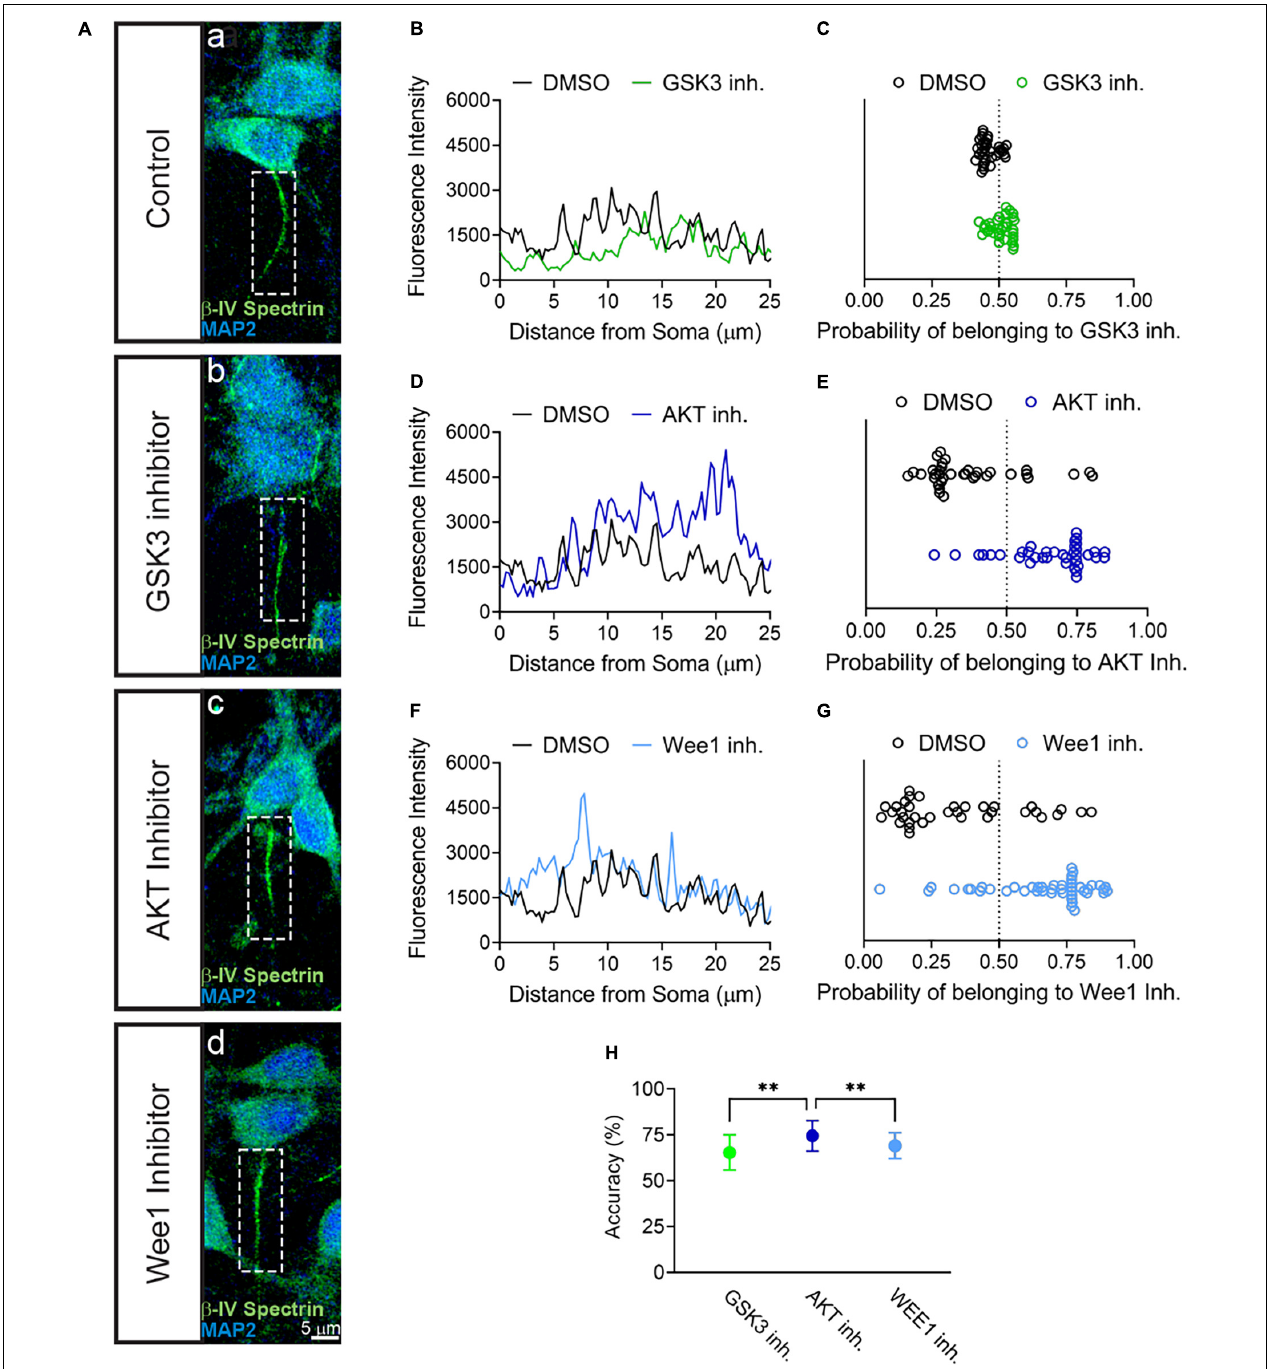
FIGURE 4 | SVM Classification of β IV Spectrin fluorescent intensity accurately sorts AKT inhibitor treated cells from control. (A) Representative images of AIS from neurons treated with (a) 0.5% DMSO (control), (b) 5 µ M GSK3 inhibitor CHIR99021 (c) 25–30 µ M AKT inhibitor triciribine, (d) 5–10 µ M Wee1 kinase inhibitor II with MAP2 in blue and β IV spectrin in green. (B,D,F) Profiles of AIS in panel (a–d) showing first 25 µ m used for SVM analysis of neurons treated with (B) DMSO versus GSK3 inhibitor, (D) DMSO versus AKT inhibitor and (F) DMSO versus Wee1 kinase inhibitor II. (C) Classification of β IV spectrin fluorescent intensity of DMSO versus GSK3 inhibitor treated neurons showing an accuracy of 66% in a sample experiment. (E) Classification of β IV spectrin fluorescent intensity of DMSO versus AKT inhibitor treated neurons showing an accuracy of 73% sample experiment. (G) Classification of β IV spectrin fluorescent intensity of DMSO versus Wee1 kinase inhibitor II treated neurons showing an accuracy of 70% sample experiment. (H) Over 100 tests from the data in panels (C–E) , SVM was able to predict cells treated with triciribine or DMSO (74.5% ± 8.3) with a significantly higher accuracy ( p < 0.0001) compared to CHIR99021 (65.4% ± 9.6) or Wee1 inhibitor II (69.1% ± 7.1). Data are mean ± SD. ∗∗ p < 0.01 by One-Way ANOVA with Dunnett’s multiple comparisons test.